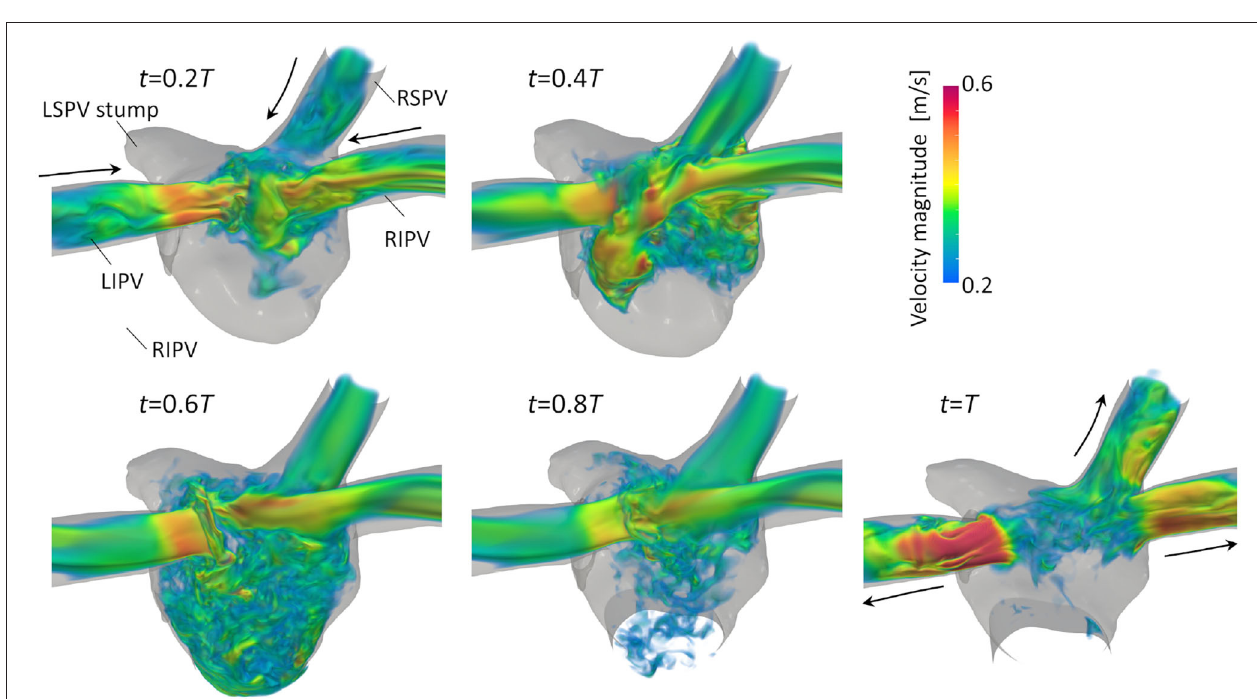
FIGURE 4 | Posterior views of the velocity distribution with volume rendering at t = 0.2 T , 0.4 T , 0.6 T , 0.8 T , and T after LULs ( T : cardiac cycle from the start of systole). Refer to Supplementary Video 1 to see the velocity transition for a whole cardiac cycle.